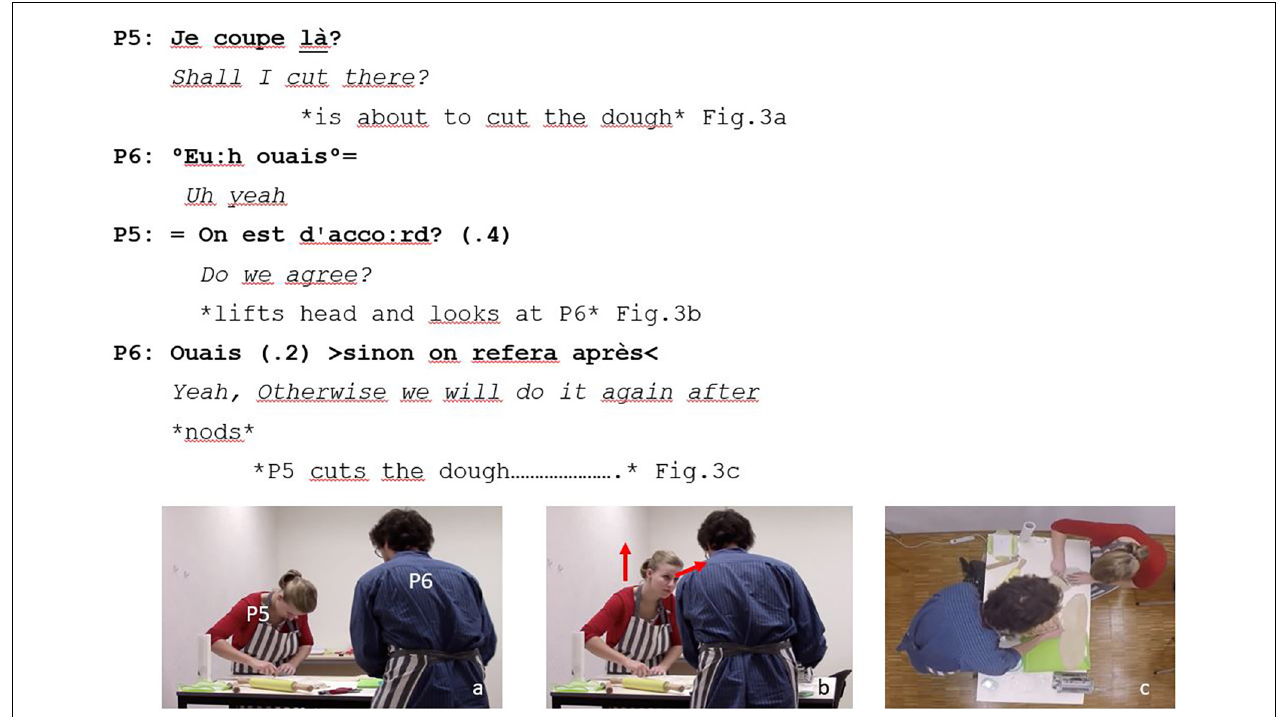
FIGURE 3 | Example of confirmation question in joint